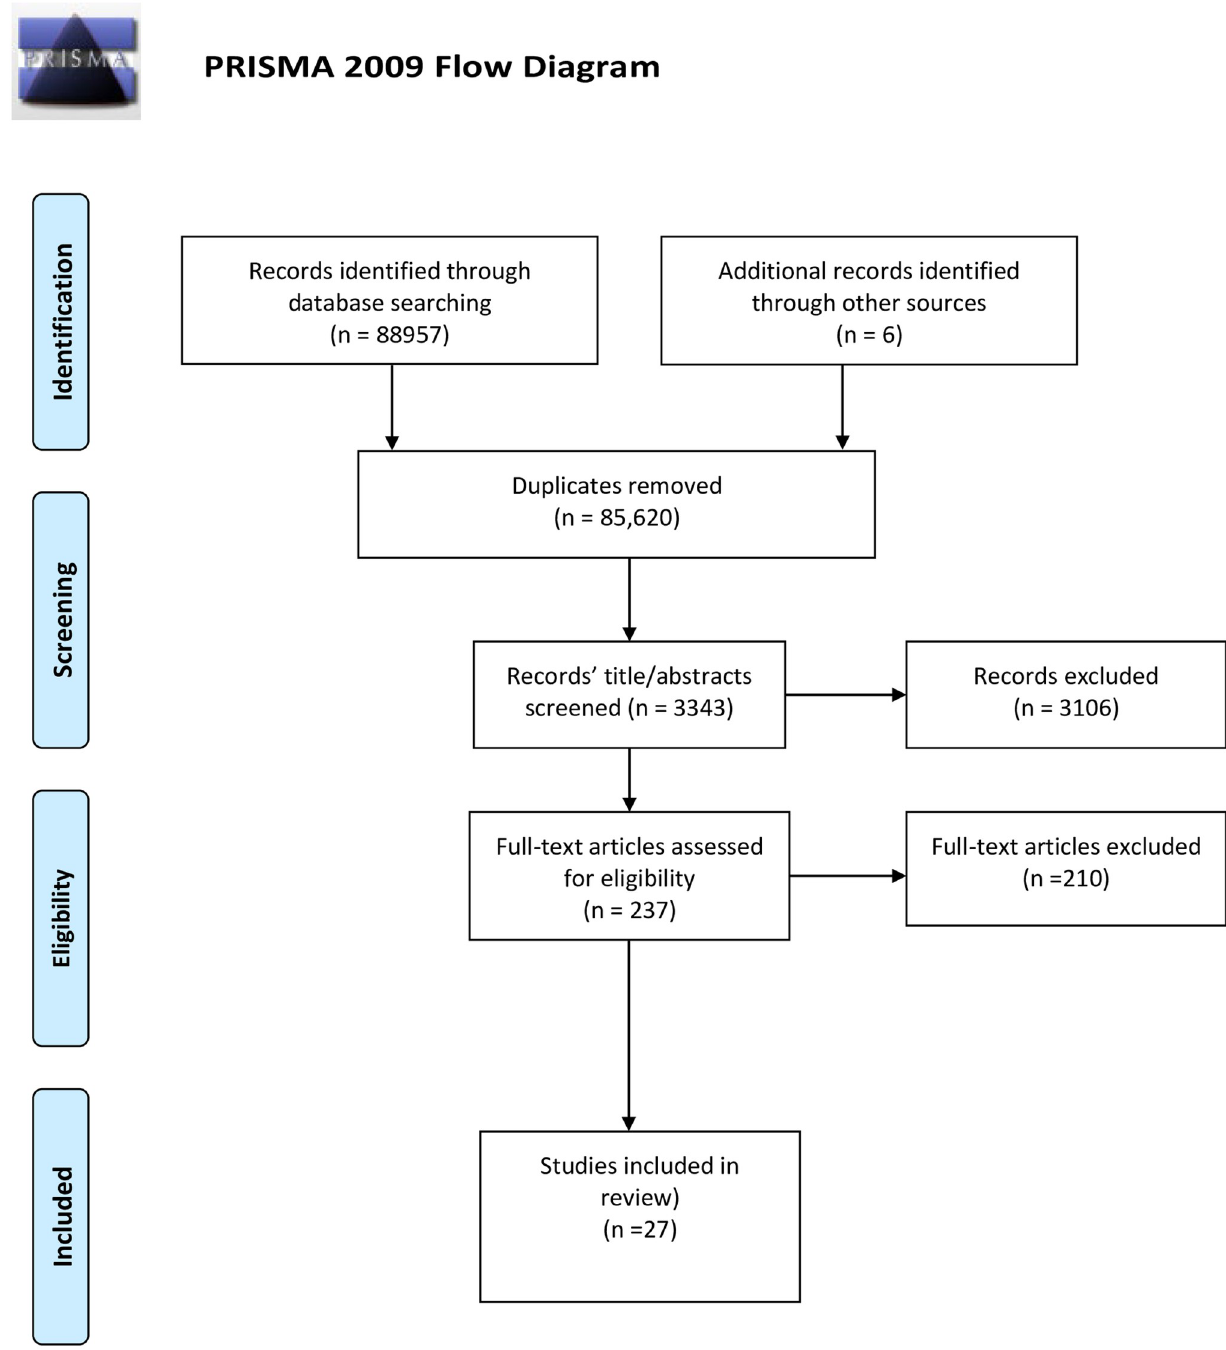
Fig 1. Patient accountability flow. From : Moher D, Liberati A, Tetzlaff J, Altman DG, The PRISMA Group (2009). P referred R eporting I terns for S ystematic Reviews and M eta- A nalyses: The PRISMA Statement. PLoS Med 6(7): e1000097. doi: 10.1371/journal.pmed1000097 For more information, visit www.prisma-statement.org.